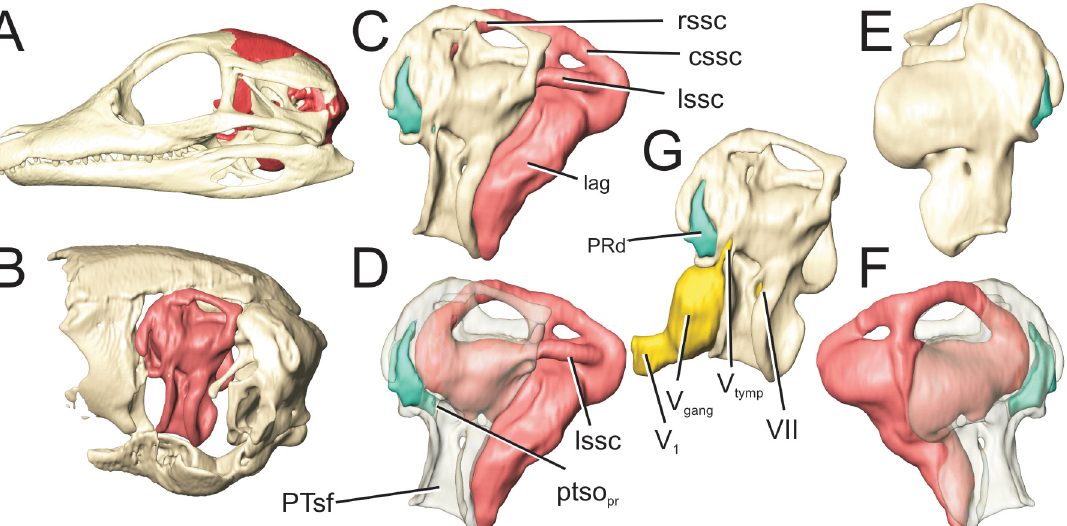
Fig 9. Perinatal Alligator mississippiensis (OUVC 10606) shown in A) left lateral view with the braincase rendered in red and B) with the braincase isolated and the prootic rendered in red. Left lateral view of C) the isolated prootic, D) rendered transparent with endosseous labyrinth and G) with associated cranial nerves. Left prootic in E) medial aspect and F) rendered transparent with endosseous labyrinth. Labyrinth is rendered in pink, and the prootic diverticulum rendered in teal. cssc , caudal semicircular canal; lag , lagena; lssc , lateral semicircular canal; PRd , prootic diverticulum; PTsf , fossa for pharyngotympanic sinus; ptso pr , communicating ostium between pharyngotympanic sinus and prootic diverticulum; rssc , rostral semicircular canal; V gang , trigeminal ganglion; V tymp , tympanic ramus of trigeminal nerve; V 1 , ophthalmic ramus of trigeminal nerve; VII , facial nerve.